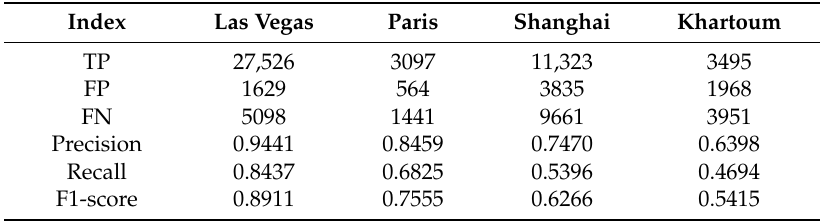
Figure 4. Examples of building footprint extraction results of our proposed method in ( a , b ) Las Vegas, ( c , d ) Paris, ( e , f ) Shanghai, and ( g , h ) Khartoum. Green, red, and yellow polygons denote correctly extracted buildings (TP), other objects extracted as buildings by mistake (FP), and ground truth buildings that were not extracted correctly by the proposed method (FN), respectively. Table 4. Results of the proposed method evaluated by the validation dataset. TP, true positive. FP, false positive. FN, false